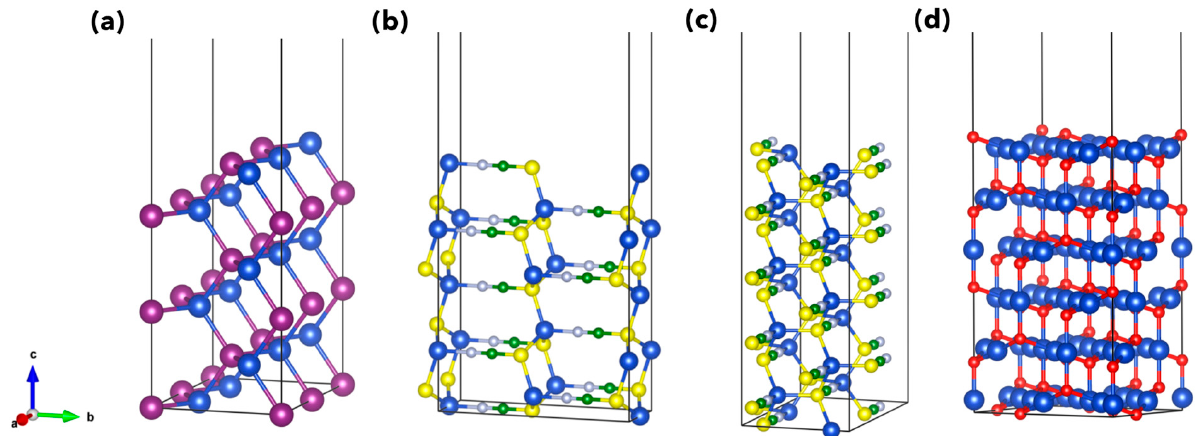
Figure 3. Slab models of (110) CuI surface ( a ), (100) and (110) CuSCN surfaces ( b , c ) and √ √ 3 × 3 R ( 30 ◦ ) (111) Cu 2 O surface ( d ). All slabs are shown before atomic relaxation. Color label for atomic spheres: Cu, dark blue; I, violet; S, yellow; C, green; N, light blue; O, red.